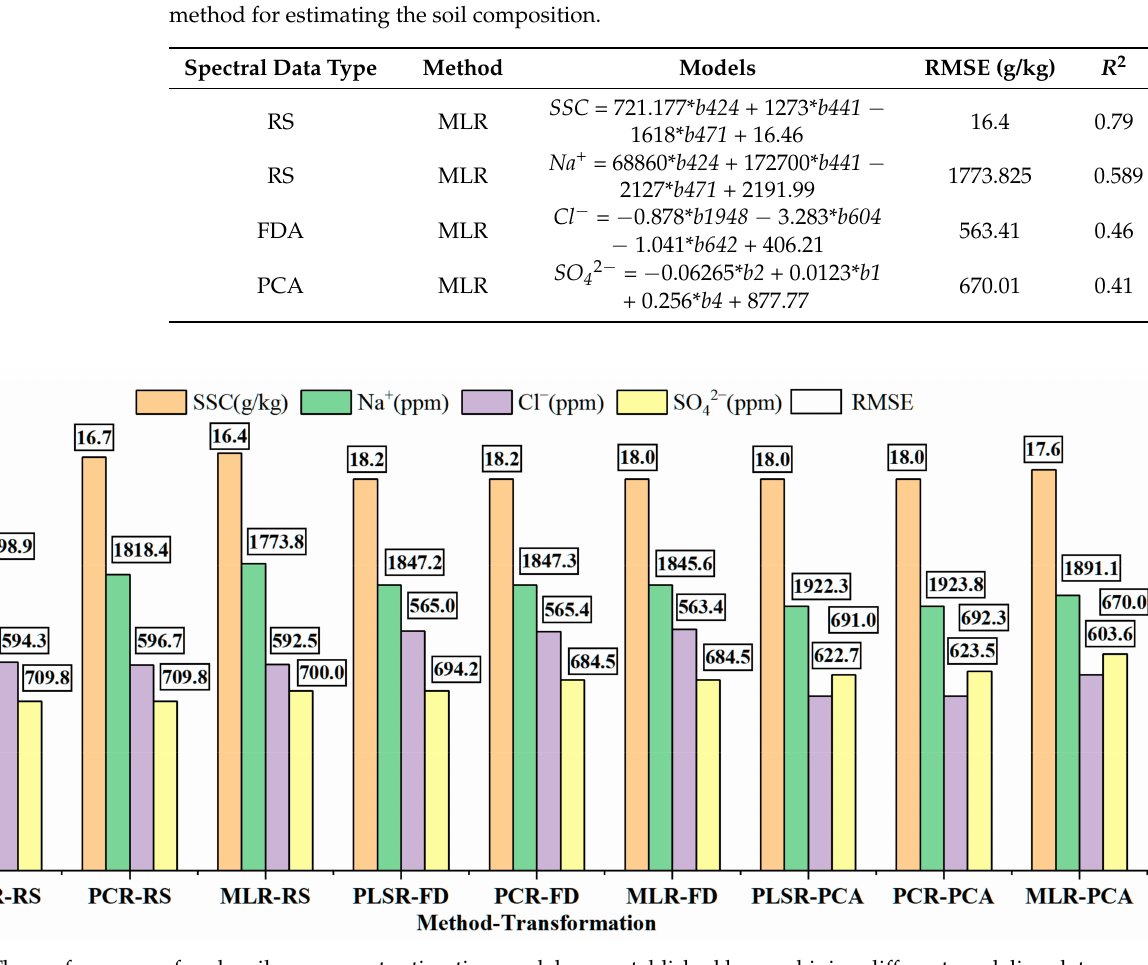
Figure 7. The performance of each soil component estimation model was established by combining different modeling data (RS, FDA, and PCA data) with different modeling methods (PLSR, PCR, and MLR). R 2 and RMSE were used to evaluate the performance of the